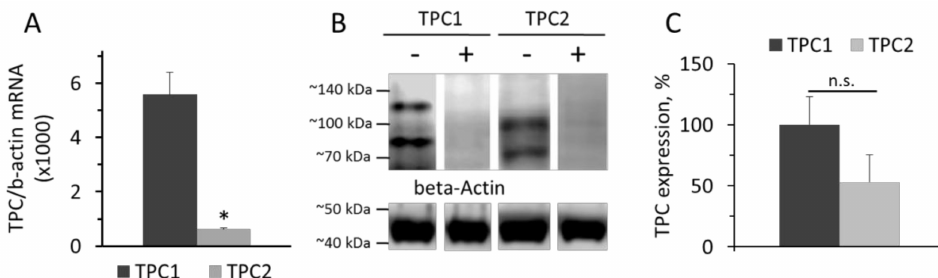
Figure 1. Levels of TPC1 and TPC2 mRNA relative to β -actin mRNA ( A ). Western-blot of TPC1 and TPC2 proteins ( B ) isolated from rat aorta SMCs and relative levels of TPC1 and TPC2 ( C ). The values panel A are the means of four measurements in di ff erent SMCs preparation + SEM (* p < 0.01). In panel B, the typical image of Western blots from one of three di ff erent cell lysates is presented. ( + ) Marks hybridization in the presence of blocking peptide. In panel C, n = 3 and n.s.—not significant. TPC1 and TPC2 expressed in SKBR3 cells are localized in the endolysosomal system [8]. To determine the subcellular localization of TPCs in SMCs, we used cis -NED 19, which is a ligand